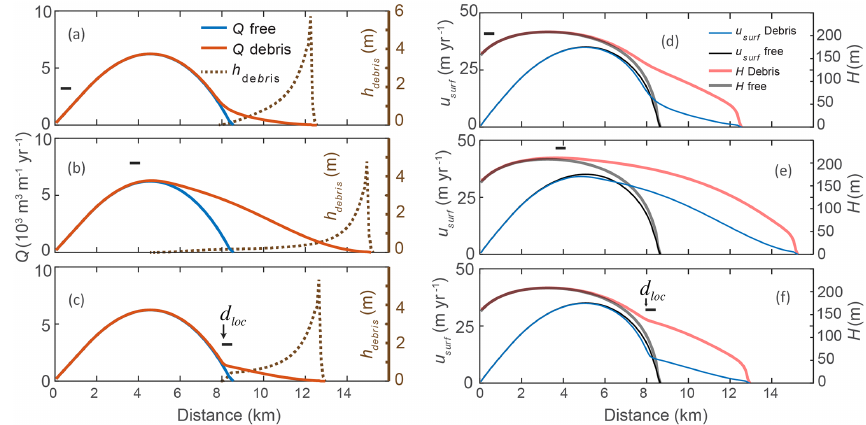
Figure 6. Modeled changes in ice fluxes, thicknesses and velocities due to debris deposition location. ˙ d flux = 3 . 2m 3 m − 1 yr − 1 for each panel and other parameters excluding d loc are from the base set. (a–c) Comparison of h debris and Q for the debris covered and debris free cases shown in Fig. 6. (d–f) Comparison of surface velocities and ice thicknesses for the debris covered and debris-free cases. (a) d loc is 7% from the headwall to the steady state debris free glacier length ( L ssdf ). (b) d loc is 42% from the headwall to L ssdf . (c) d loc is 98% from the headwall to L ssdf . (d) d loc is 7% from the headwall to L ssdf . (e) d loc is 42% from the headwall to L ssdf . (f) d loc is 98% from the headwall to L ssdf